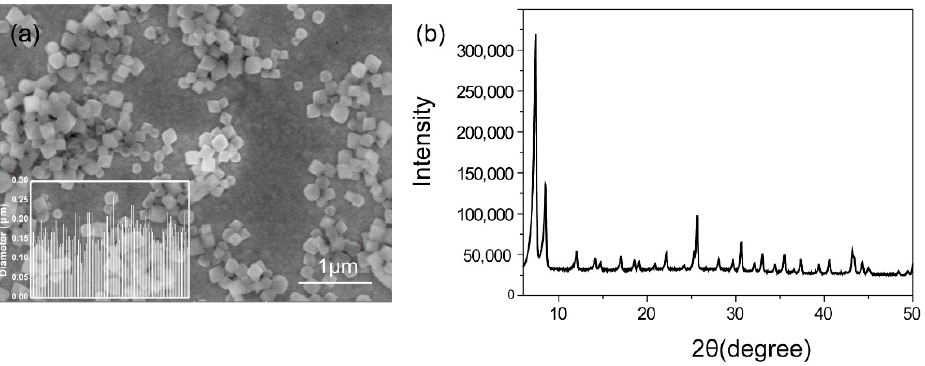
Figure 1. ( a ) SEM images of UiO-66-NH 2 nanoparticles (insert: histogram graph of diameter). ( b ) XRD pattern of synthesized UiO-66-NH 2 nanoparticles. Table 2. Experimental arrangement and results based on the L 9 (3 4 ) orthogonal table.